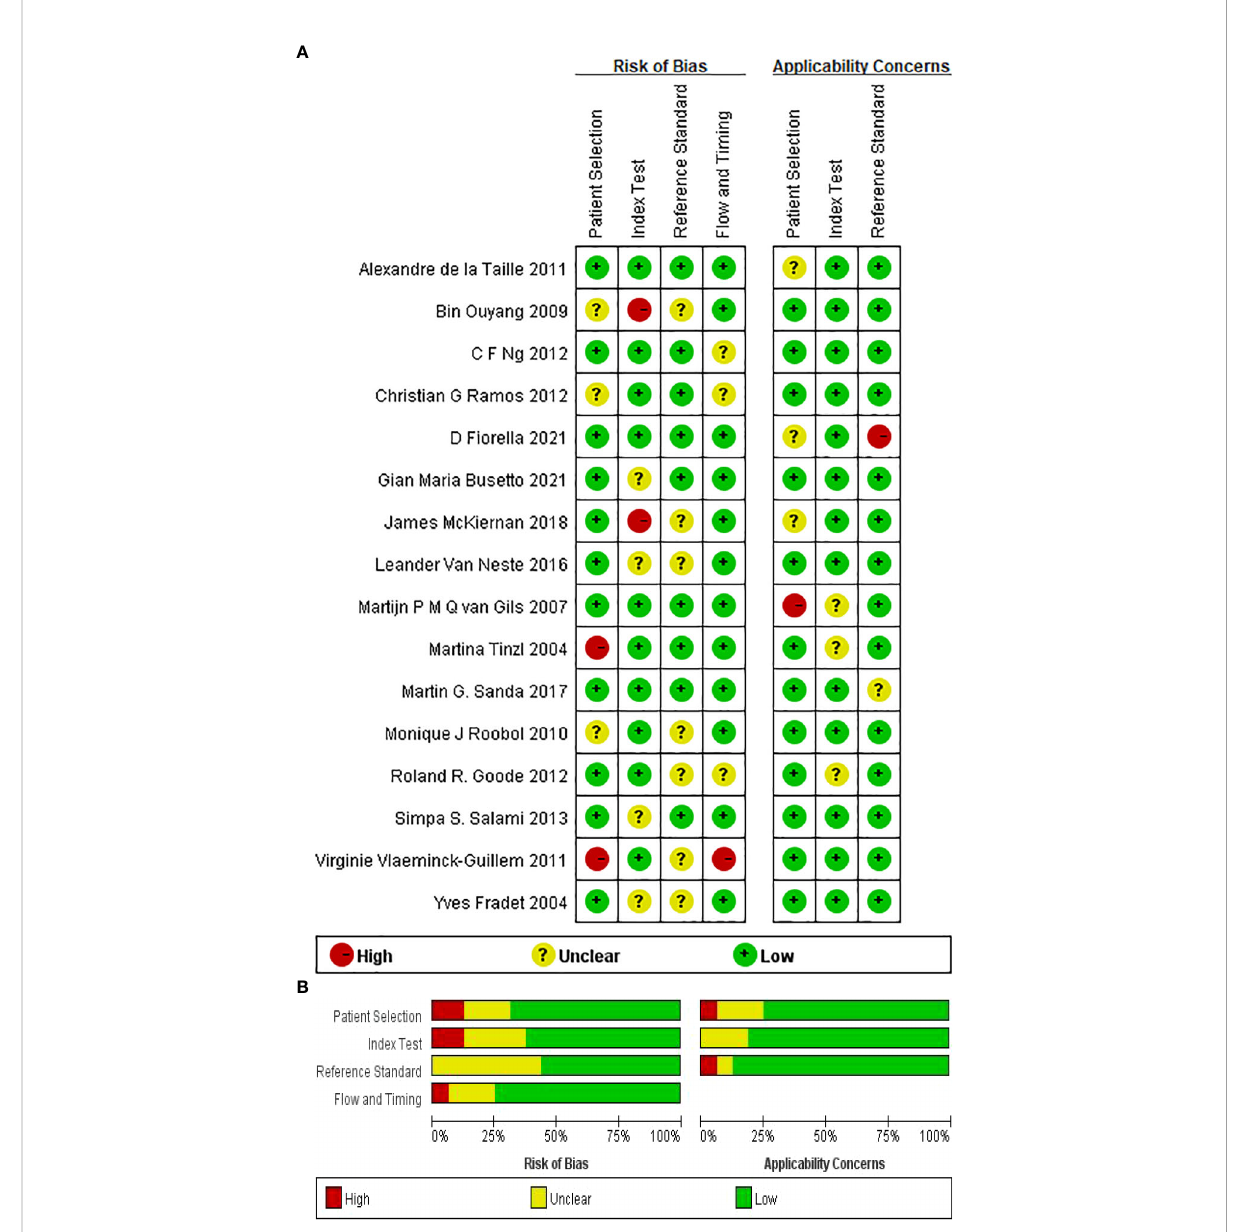
FIGURE 2 (A) Summary of risk of bias for each studies. (B) Proportion of risk of bias for all